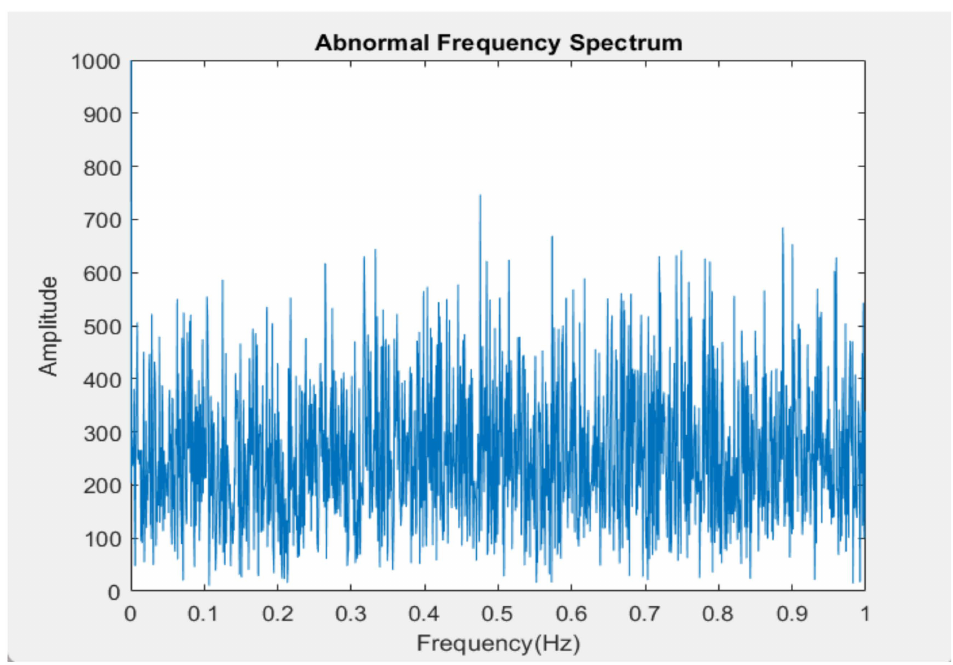
Figure 5. FFT data of an “abnormal” data